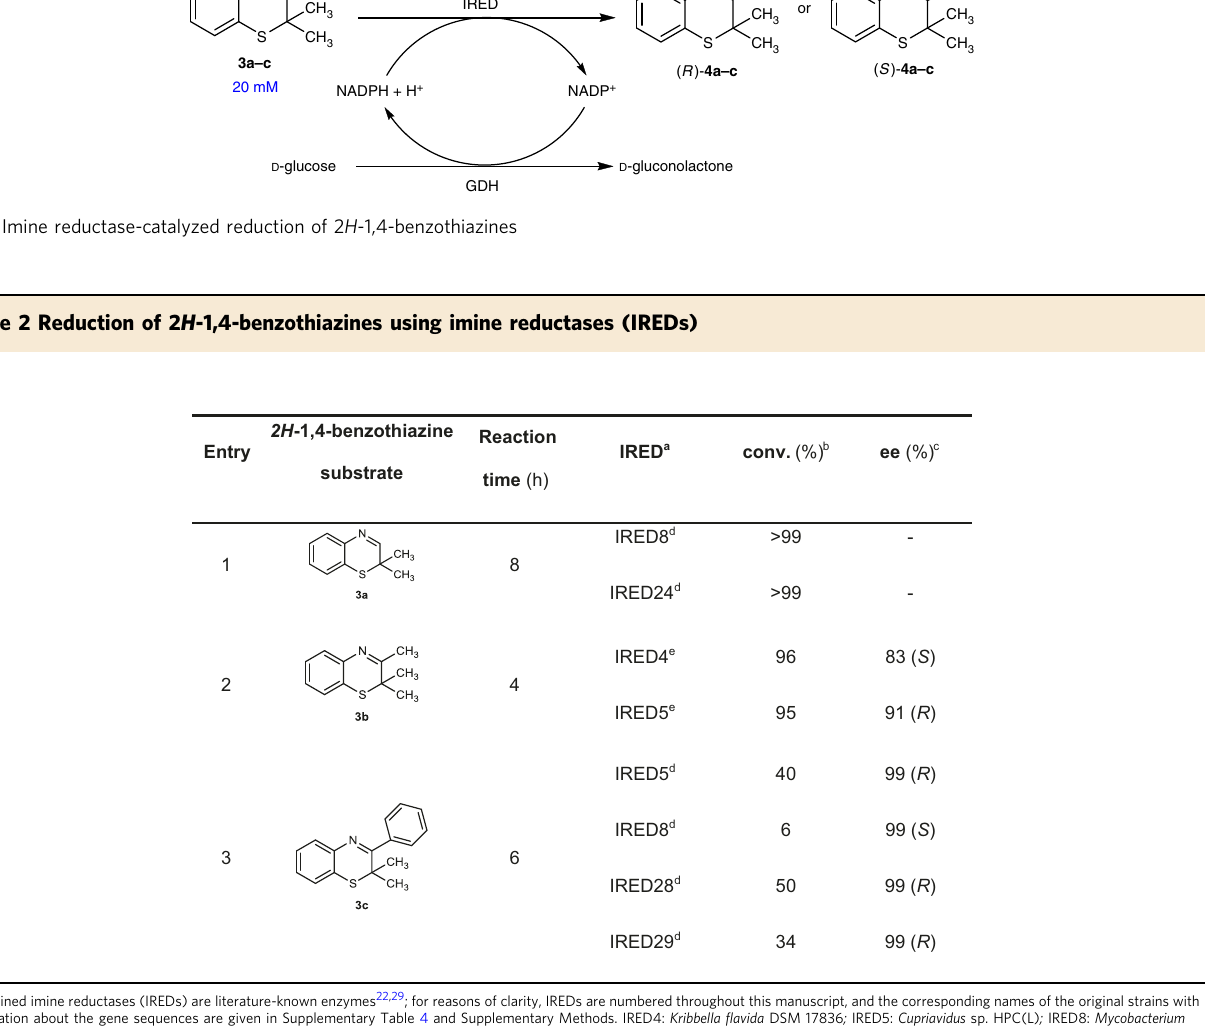
differences in the free energies of activation were obtained with parameters for water (17 kcal/mol vs. 13 kcal/mol) and chloro- form (20 kcal/mol vs. 15 kcal/mol).